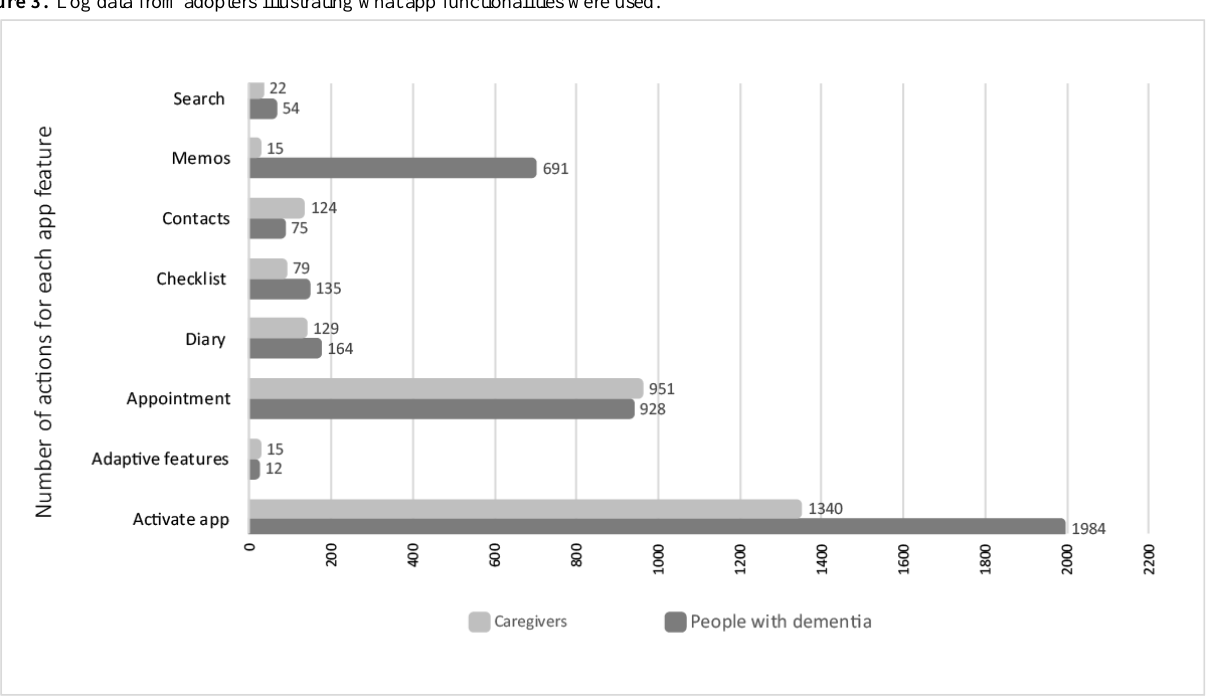
Figure 3. Log data from adopters illustrating what app functionalities were